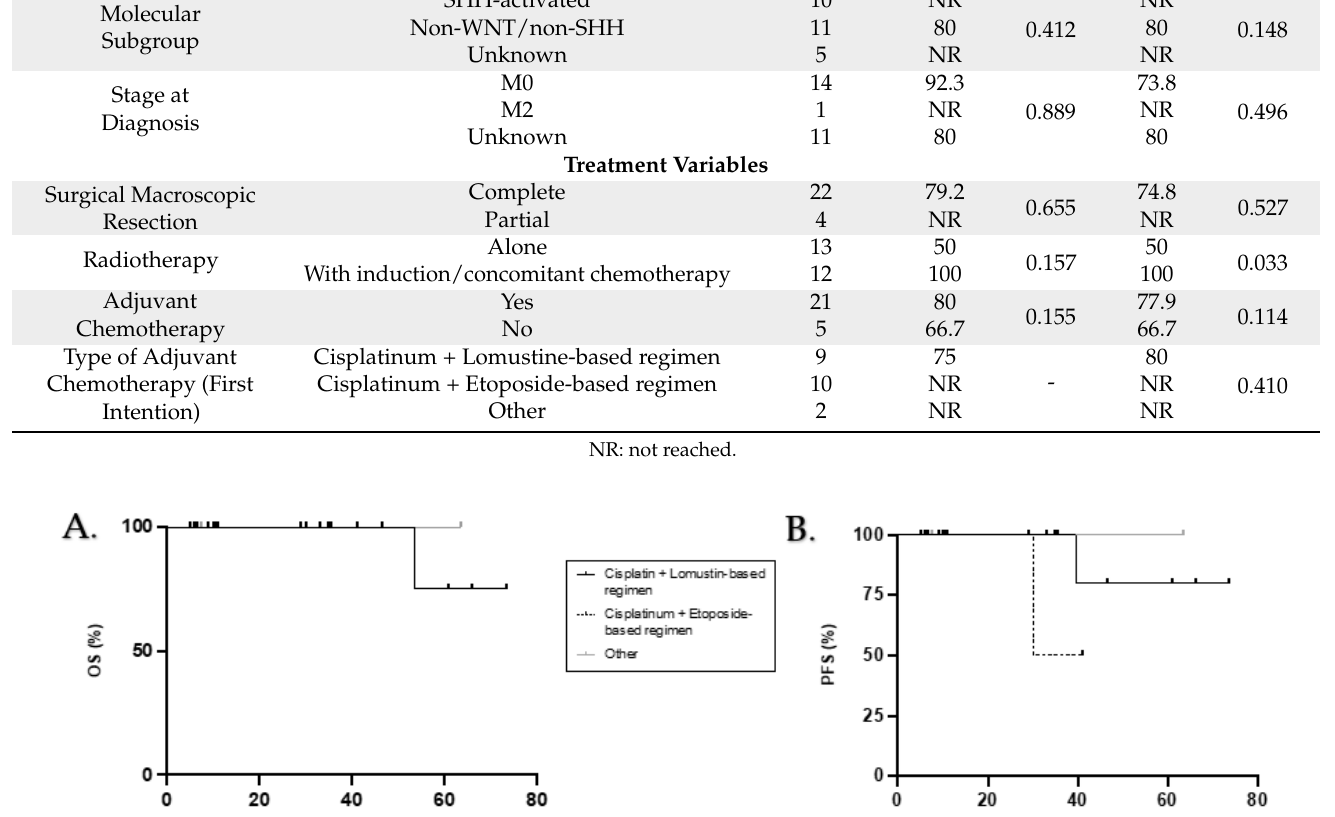
Figure 4. Kaplan–Meier overall survival ( A ) and progress-free survival ( B ) curves for all adult patients included in this study according to year of diagnosis. 4. Discussion Our study comprises the most recent adult MB patient series in North America and is the only series consisting of primarily French-Canadian patients. All patients were fol- lowed at the main reference centre for adult MB in the province of Quebec. Given the rarity of MB in the adult population, this review stands as one of the biggest ones of its kind in current literature. The characteristics of the children treated at the CHUM was included in Table 1 for reference and comparison to the paediatric population that has been described in litera- ture, as well as to the adult population specific to this study. Children were not included in our discussion as the scope of this study is limited to adults. Furthermore, the infor- mation on the treatment regimen used in children was limited as they were typically seen at our centre for radiotherapy only.